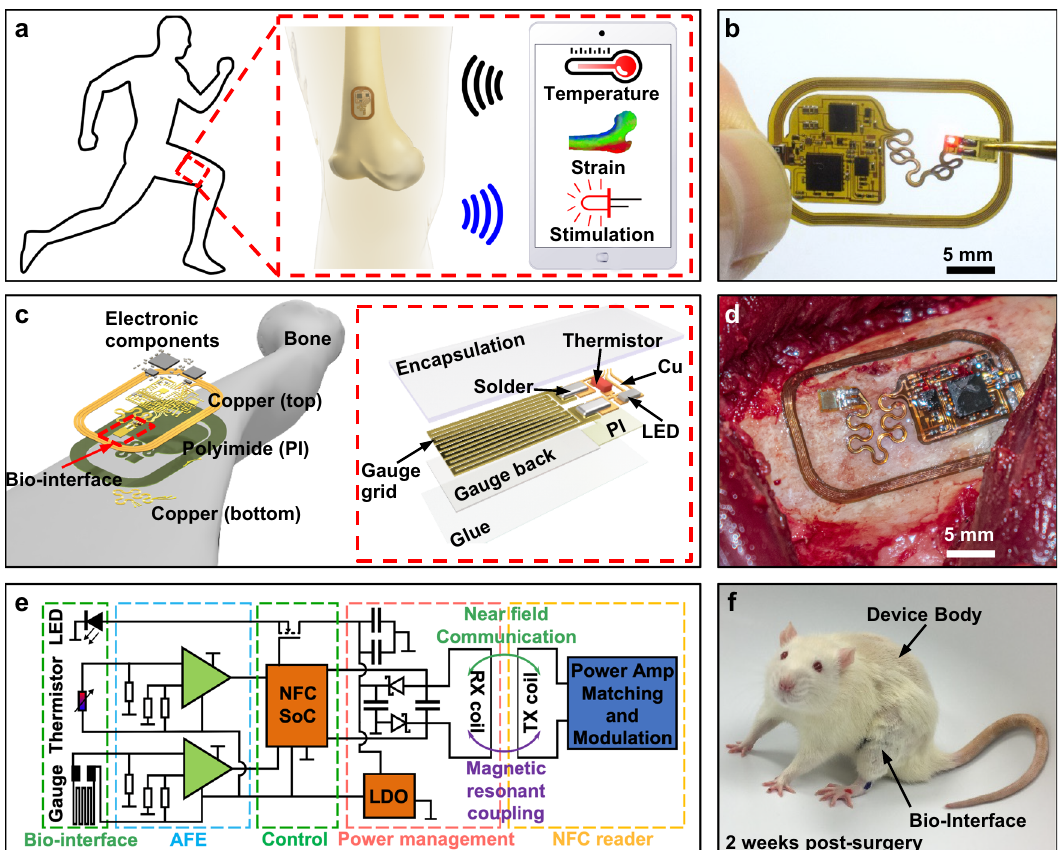
Fig. 1 Osseosurface electronics: concept, device architecture, and implementation strategies. a Illustration of osseosurface electronic systems that are permanently bonded to the bone and operate wirelessly to continuously monitor biophysical signals such as bone strain, local temperature, and to deliver optical stimulation to the bone and surrounding tissues. b Photograph of an osseosurface device designed for studies in large animal models. c Layered makeup of the osseosurface system and its constituent layers. Inset features a close-up view of the multifunctional biointerface comprised of a metal-foil strain gauge, an NTC thermistor, and a µ -ILED. d Photograph of an osseosurface device conformally attached on the surface of a sheep humerus. e Functional block diagram of osseosurface electronics comprised of an external NFC reader that provides power and facilitates wireless communication, and an implanted system that contains active power management, operational control, analog front-end (AFE), and biointerface. f Photograph of a rat (2 weeks after surgery) implanted with an osseosurface device where the main electronics reside on the back while the biointerface is routed and attached on the left